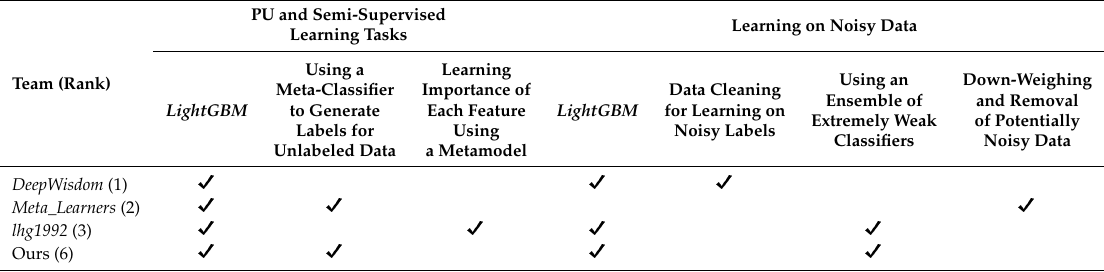
Table 12. Tabular: Brief overview of ingredients used by leading submissions in the AutoWSL